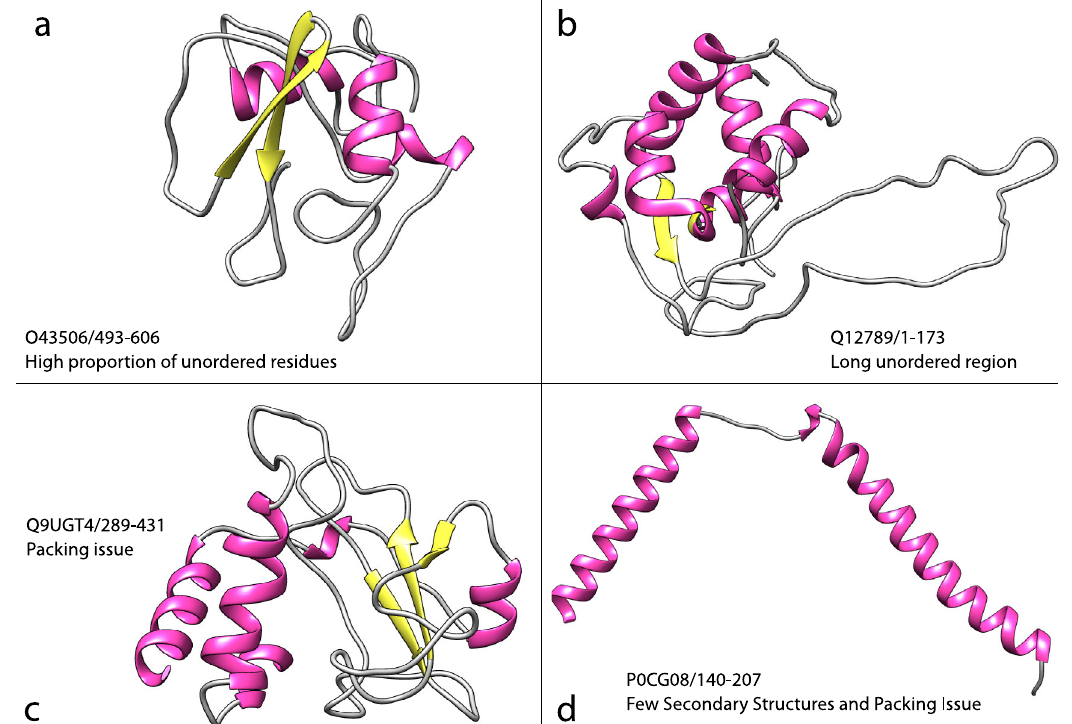
Fig. 7 Issues encountered when processing domains not assigned to CATH. Each structure fi gure was generated using UCSF Chimera 36 , with identi fi ers in the format UniProt_ID/start-stop. Examples of poor models a High proportion of unordered residues. b Presence of long unordered regions. c Residue packing problems. d Less than three secondary structures and packing